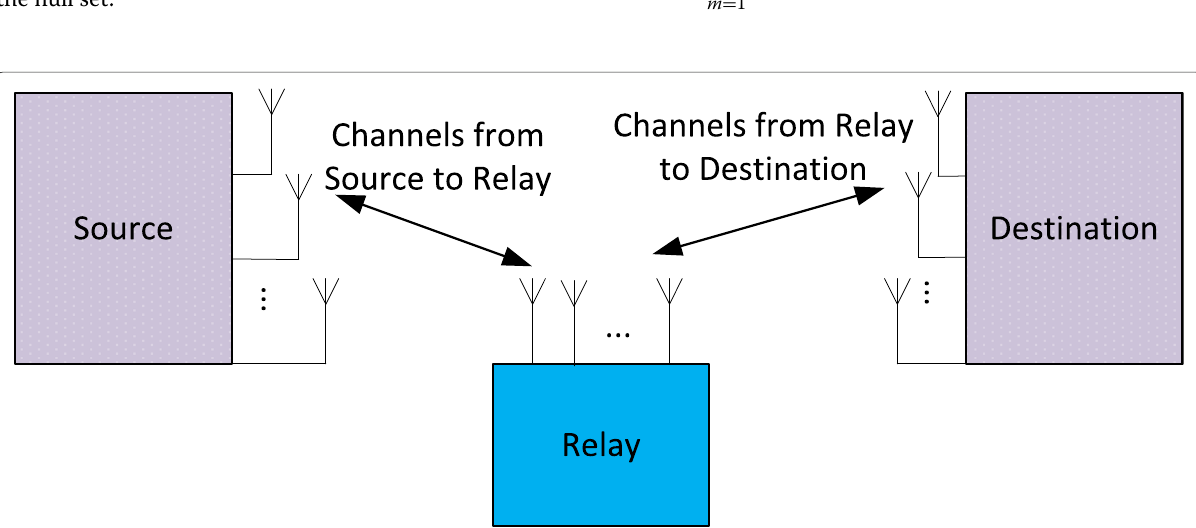
Fig. 1 Conceptual system model for a MIMO-OFDM relay network and joint